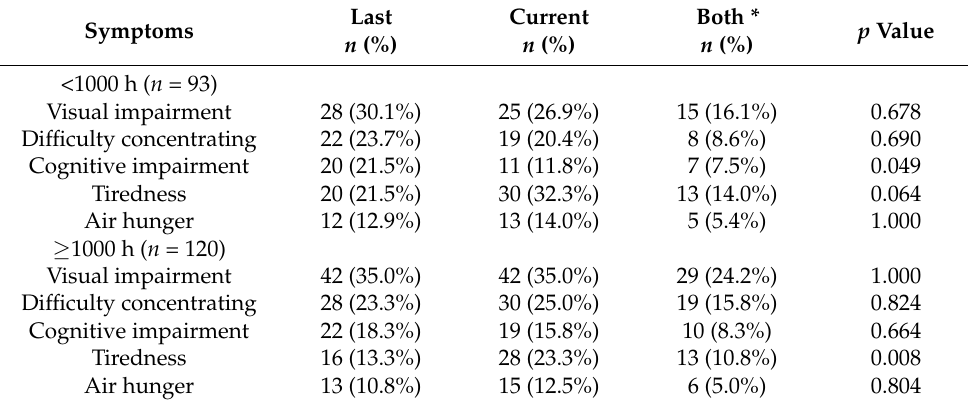
Table 3. Comparison of hypoxia symptoms between the last and current the altitude hypoxia trainings stratified by flight hours.